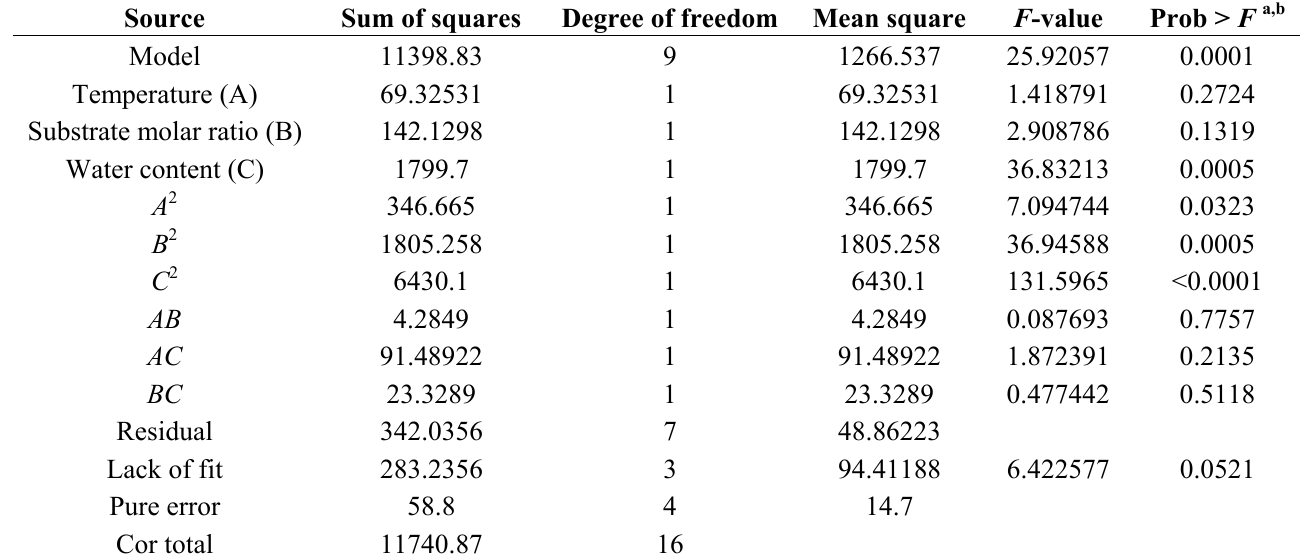
Figure 4. Contour plots of the molar conversion of FAME at different water